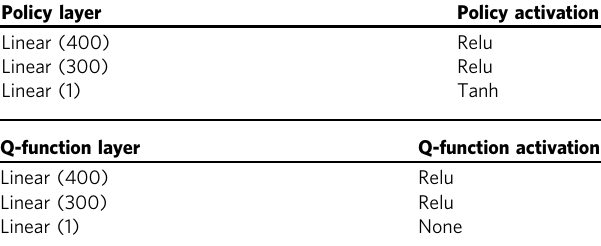
Table 4. The operation goes on until either the agent reaches the goal, at which point it receives a reward of 50, or 200 steps are exceeded. At this stage, the environment is reset, giving place to a new episode. This algorithm is repeated for a prede fi ned number of episodes. Transfer learning . We employed TL when changing only a single physical parameter for all of the numerical experiments presented in this paper. For the initial exploration presented in Fig. 3, we started with F max ¼ 1 N, m = 1 kg and η = 2 kg s − 1 . Then, we